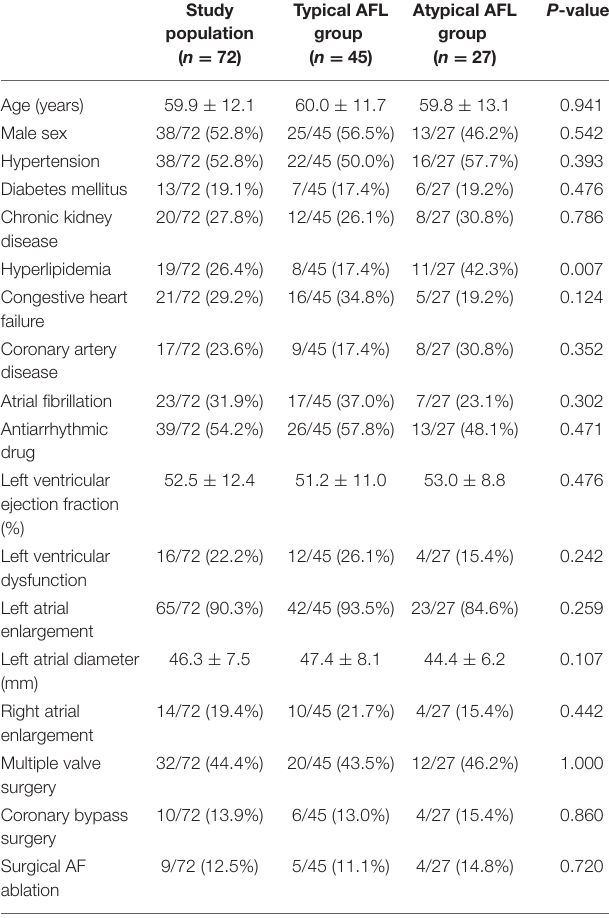
TABLE 1 | Baseline characteristics of the study